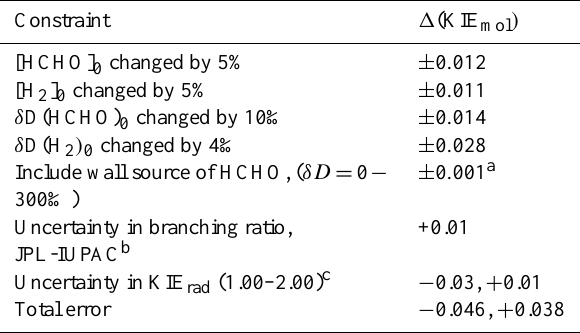
Table 3. Sensitivity of optimized KIE mol values to changes in im- portant reaction parameters. KIE rad is always fixed at 1.63.